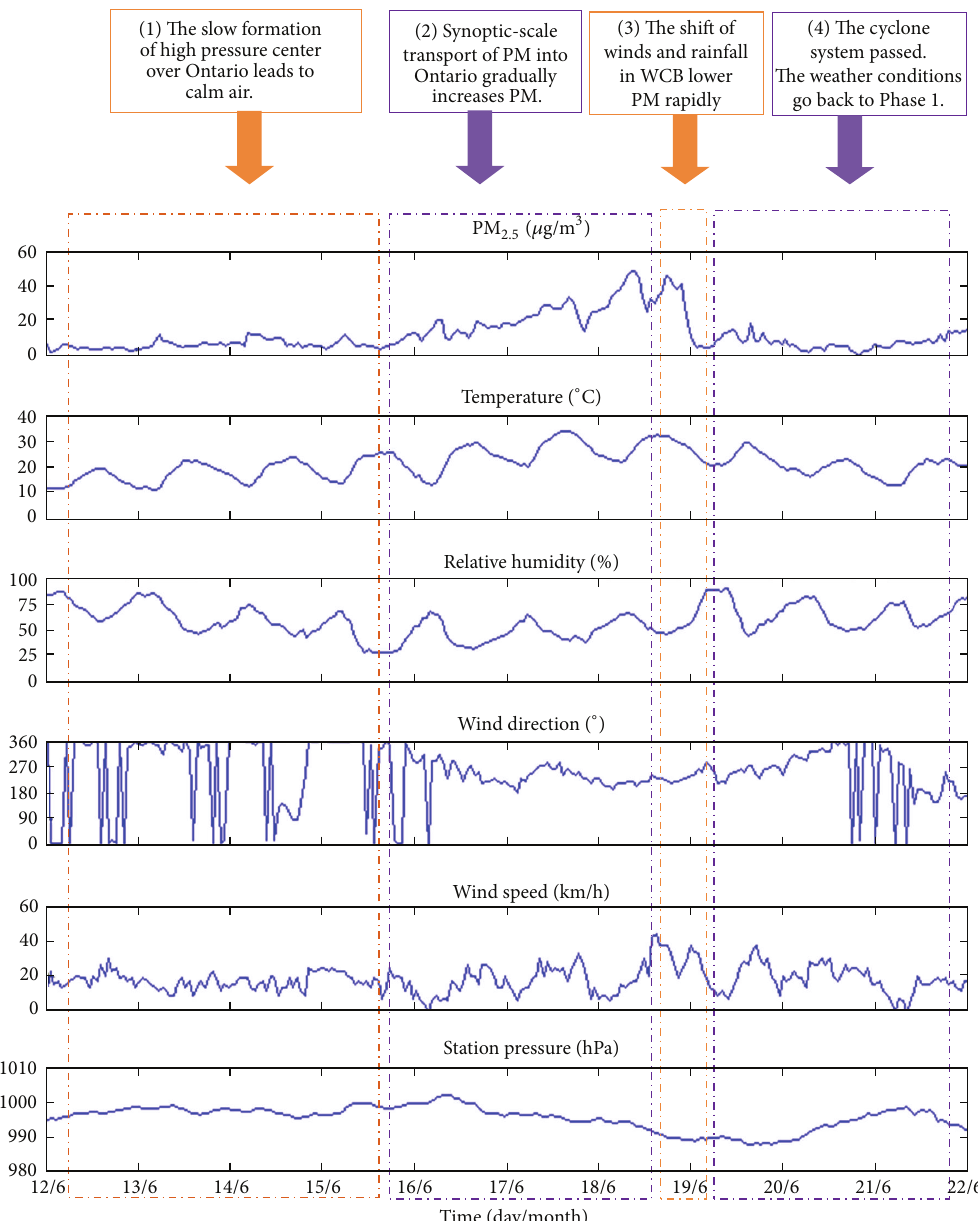
Figure 6: Hourly PM 2.5 and the surface meteorological variables including air temperature ( ∘ C), relative humidity (%), wind direction ( ∘ ), wind speed (km/h), and surface pressure (hPa) between June 12 and June 22, 2006, at